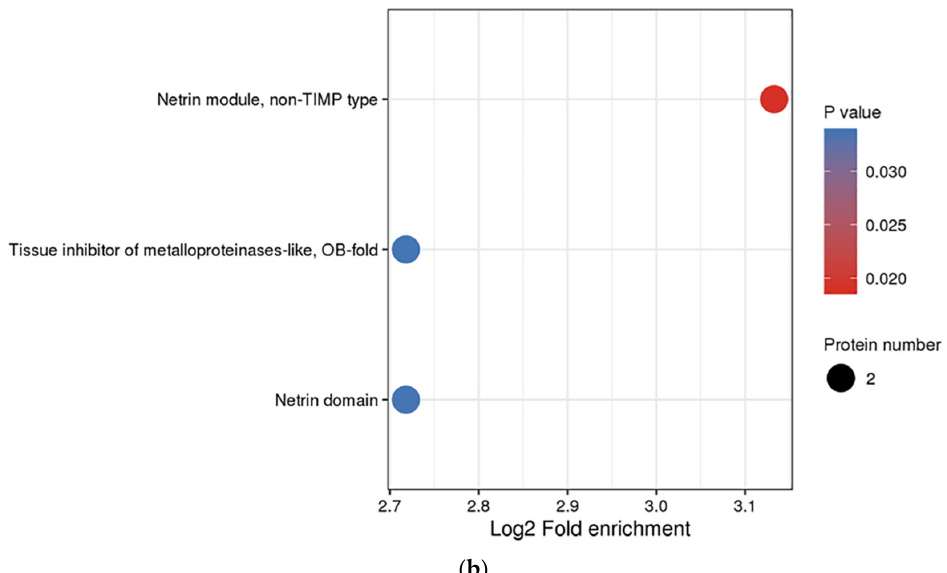
Figure 5. KEGG pathway and protein domain enrichment bubble plot of the 24 DEPs. ( a ) KEGG pathway enrichment analysis of the 24 DEPs. KEGG analysis provides information on molecular networks and their interaction, complexes, and biochemical reactions. ( b ) Repeatative component of proteins that appear regulary are know as protein domains, which generally include 25 to 500 amino acids in length. The significance of enrichment p -values is represented by colors. The circle size signifies the number of DEPs in each functional class or pathway.